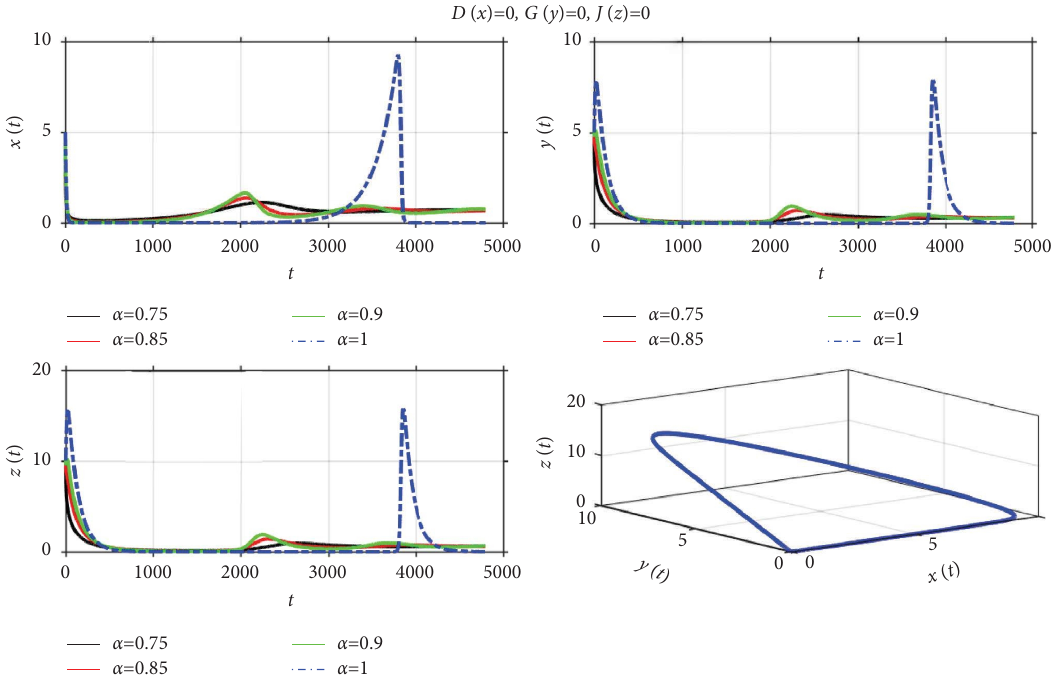
Figure 2: Population dynamics of the one prey-two predators system with D ( x ) � 0 , G ( y ) � 0 , and J ( z ) � 0 ,a � b � c � 0 . 1 , e � h � 0 . 3 , f � i � 0 . 2 , and α � 0 . 75 , 0 . 85 , 0 . 9 , 1; and 3D-plot of x ( t ) ,y ( t ) , and z ( t ) for α � 1 .